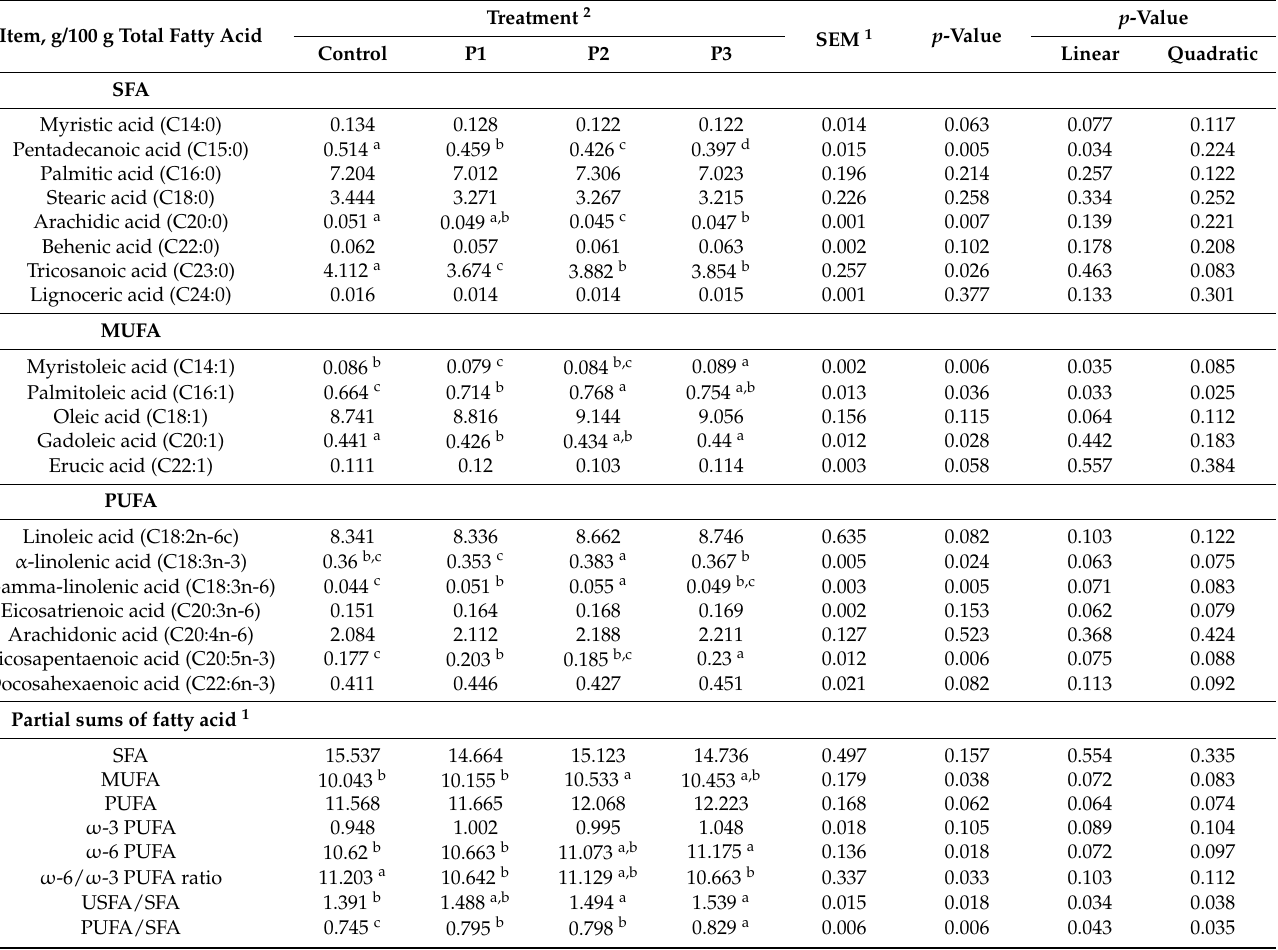
Table 5. Effect of dietary supplementation with dried jujube powder on the fatty acid composition of broiler breast